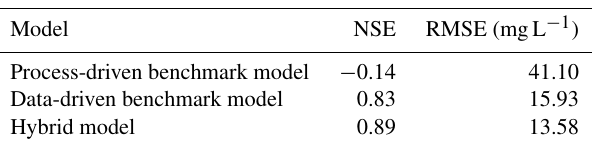
Table 5. Performance statistics for the two benchmark models and the hybrid model for the validation